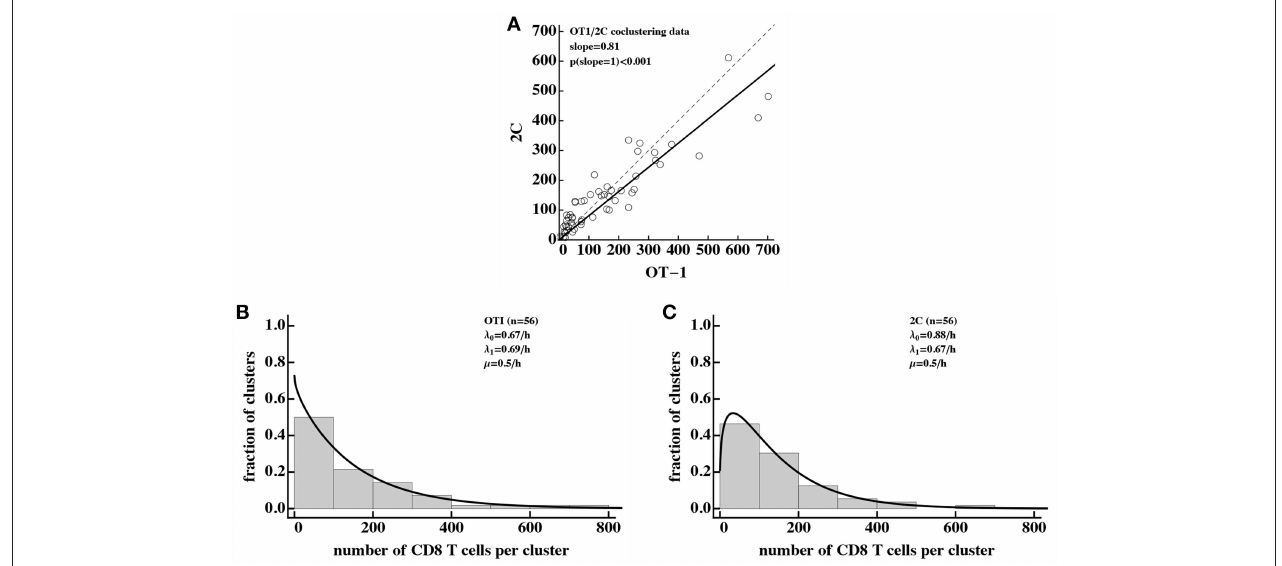
FIGURE 7 | Density-dependent recruitment model is consistent with formation of large clusters. We analyzed the data on co-clustering of Plasmodium berghei (Pb)-specific (OT-1) and control (2C) CD8 T cells from a recently published study ( 31). (A) There is a bias in cluster sizes toward more Pb-specific CD8 T cells per cluster. (B,C) The data on cluster distribution and fits of the DD recruitment model assuming that OT-1 (B) or 2C (C) cluster independently. In fits we fixed the exit rate from the cluster to µ 0.5 k / h. Because the experimental data were sparse and frequency of clusters of a given size were the same for different clusters, we plotted = the data as a histogram by binning the data into bins with the bin size of 100. To visualize the model fits of the data, we therefore multiplied the model predictions in (B,C) by 100. Best fit parameters and estimated 95% CIs are for (B) : λ 0 λ 1 0.67 (0.65 0.68) / = −